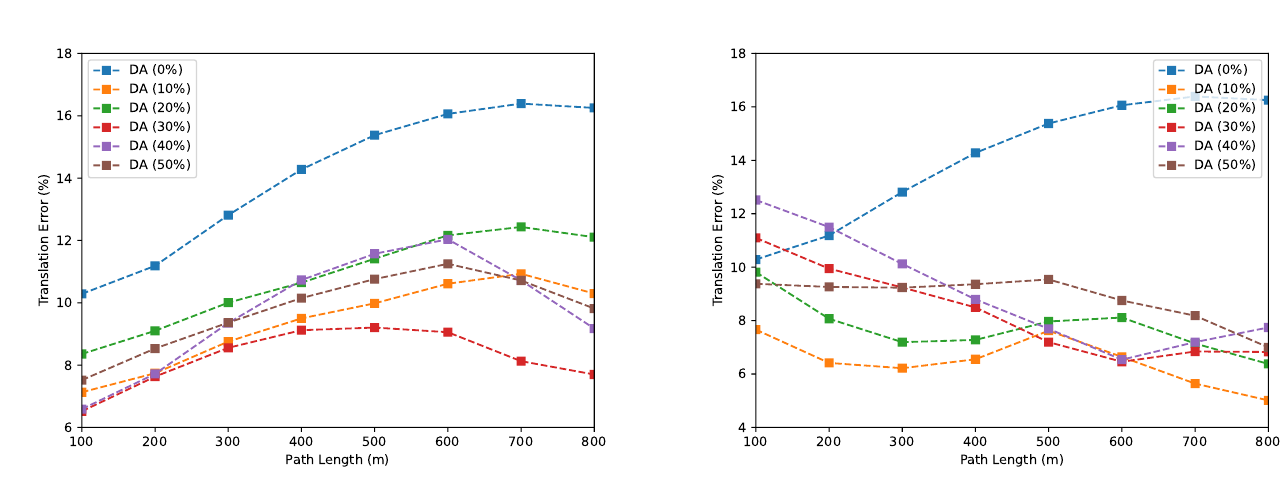
( a ) Rotational error (Sequence 09). ( b ) Rotational error (Sequence 10).